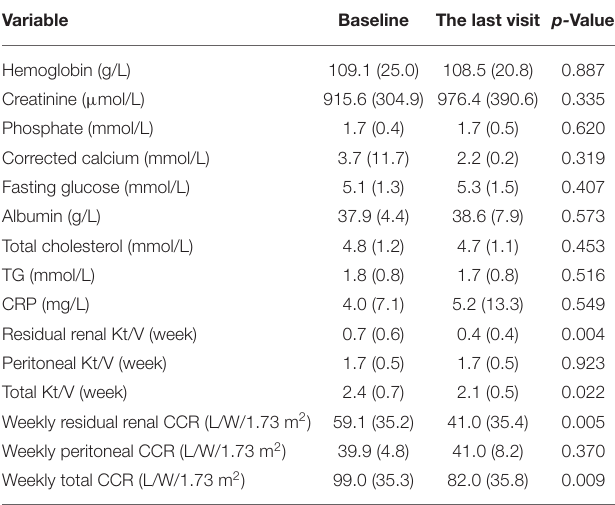
TABLE 3 | Comparison of patient’s characteristics at baseline and the last visit. Variable Baseline The last visit p- Value